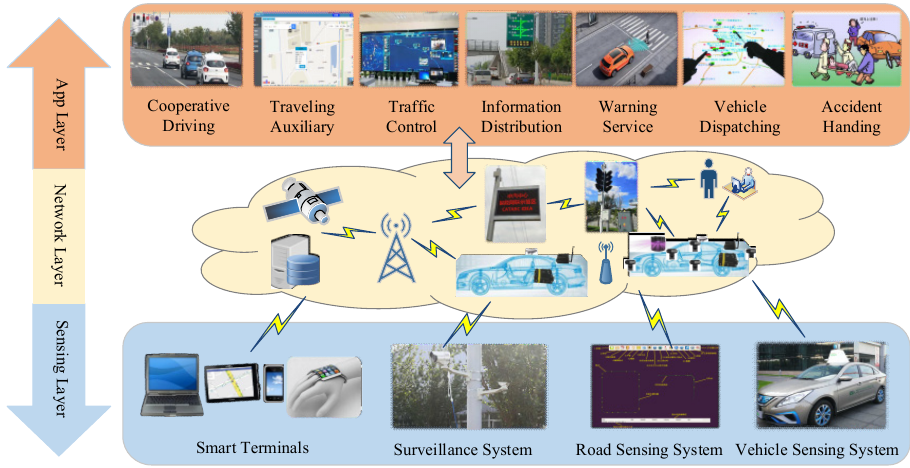
Figure 2. Conceptual framework of extended CWS.